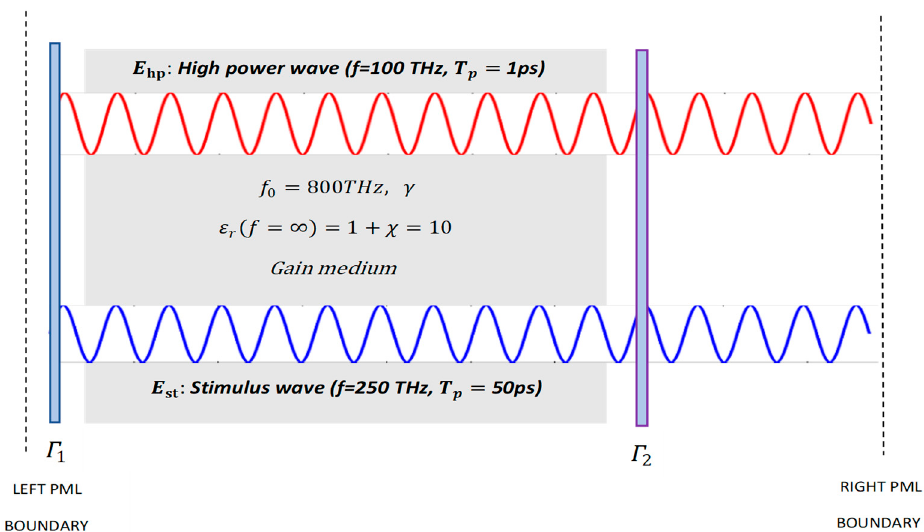
Figure 15. The cavity described along with the given parameters.